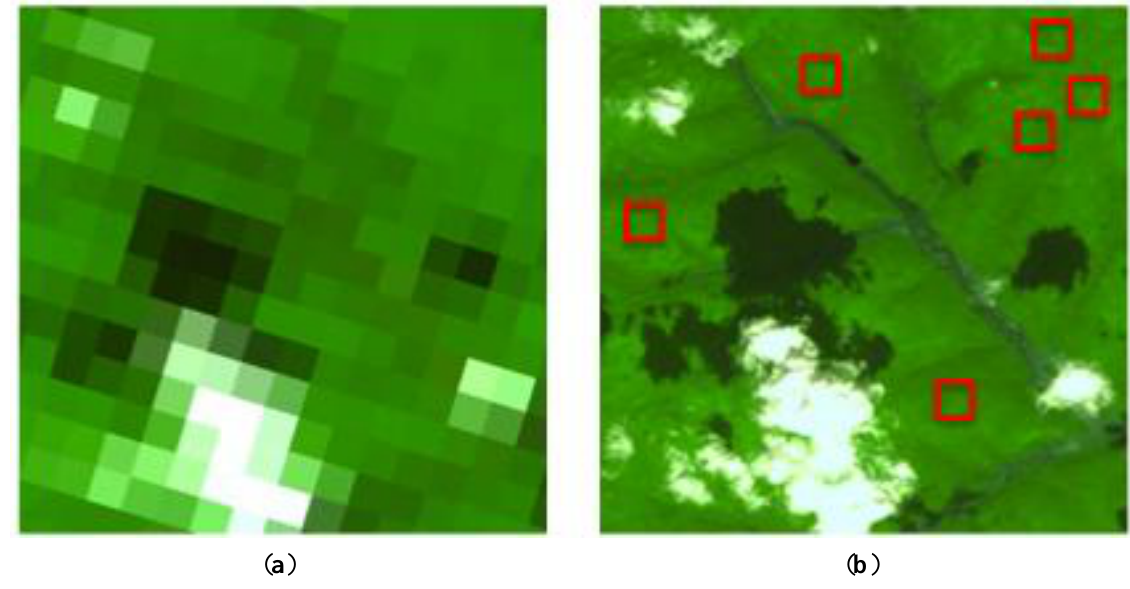
Figure 3. Example of MODIS ( a ) and ASTER ( b ) pixel extractions. This area is classified as Deciduous Needle-leaf forest (Yakutsk, Russia) on MODIS 2007 IGBP. Each red box in (b) corresponds to a 3 km-by-3 km extraction area, that is, a 201-by-201 pixel area on ASTER and a 6-by-6 pixel area on